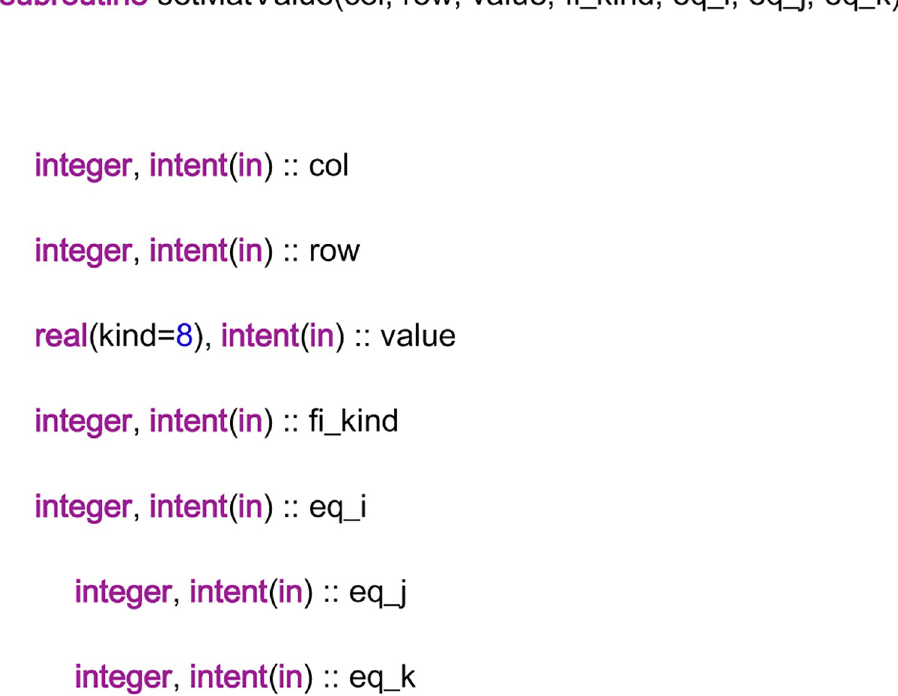
Fig 13. The head part of the code of the subroutine